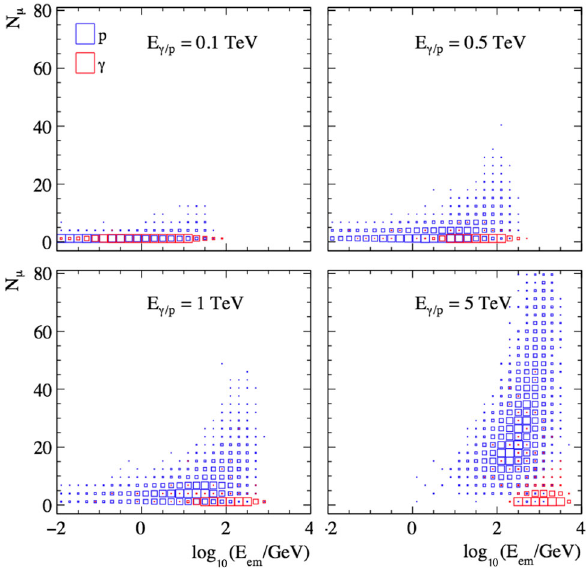
Fig. 3 Distributions of the number of muons within 100 m of the impact point as a function of ground-level electromagnetic energy for verticalshowersobservedat5kmaltitude.Proton(blue)and γ -ray(red) initiated showers of different energies are shown, with the area of the squares scaling linearly with density